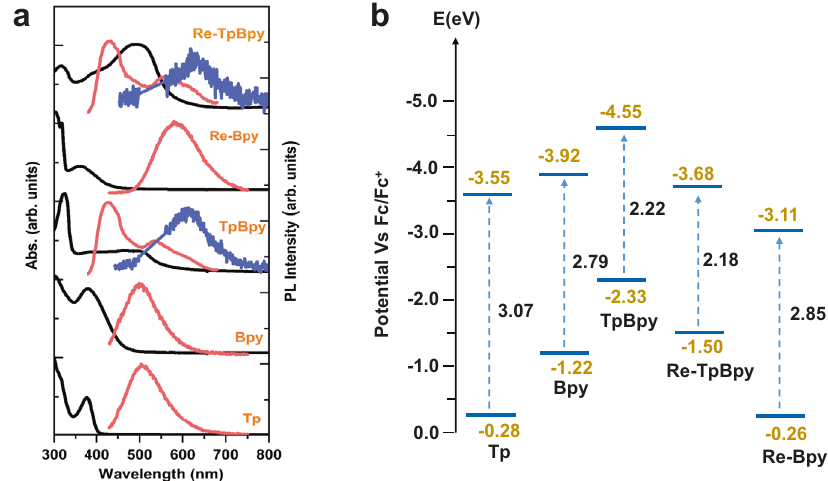
Fig. 2 Steady-state spectroscopy characterization and energy band alignment. ( a ) Normalized UV − vis absorption (black) and steady-state photoluminescence spectra excited at 400 nm (red) and 530 nm (blue) of TpBpy, Re-TpBpy and their starting materials dispersed in Na fi on (5% w/w in water and 1-propanol). ( b ) Band alignment established from both absorption spectroscopy and cyclic voltammetry. Source data are provided as a Source data fi